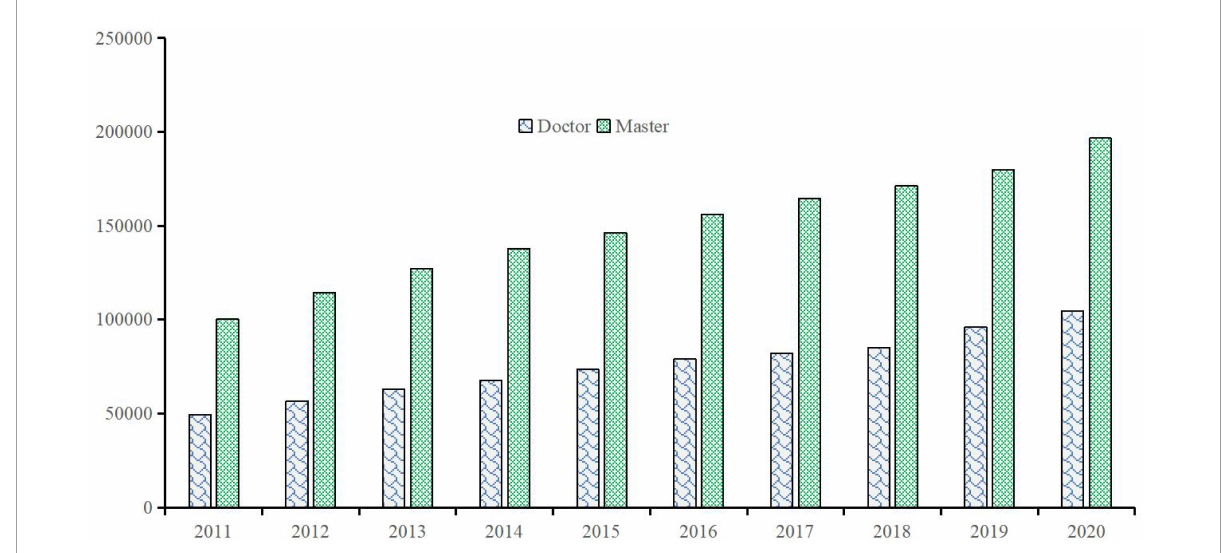
FIGURE1 Number of R&D personnel in R&D institutions in China during 2011–2020 (person). Source: The author obtained the data from the China Statistical Yearbook on Science and Technology.